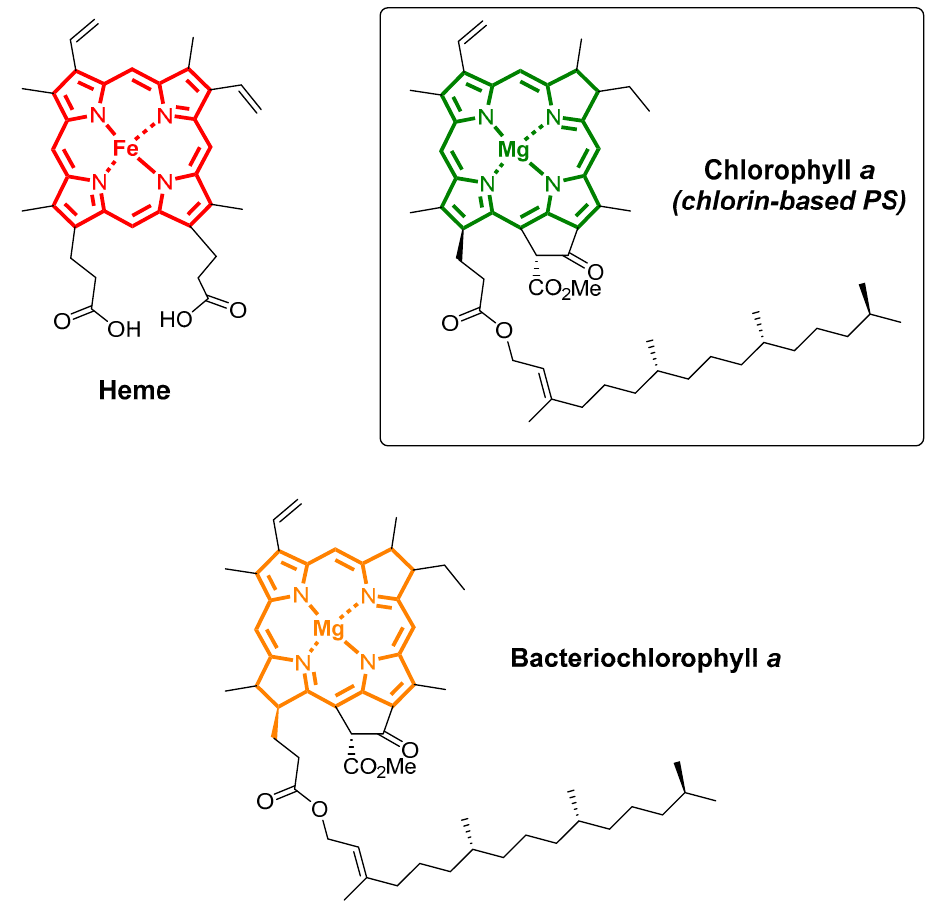
Figure 4. Tetrapyrrolic macrocycles that are involved in natural processes.